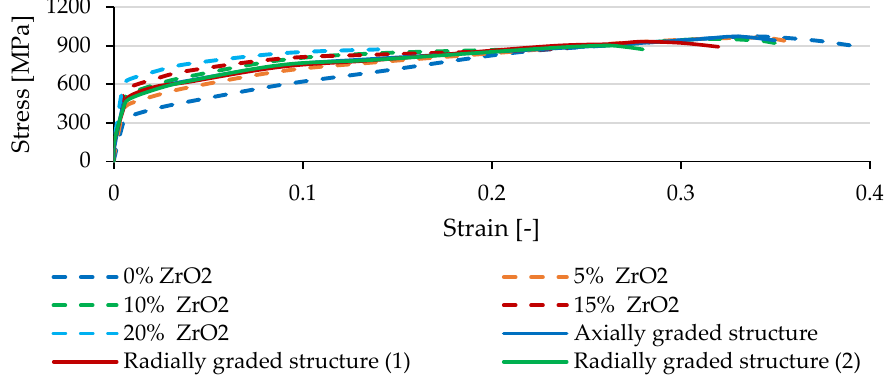
Figure 13. Changes in mechanical properties with ZrO 2 distribution.